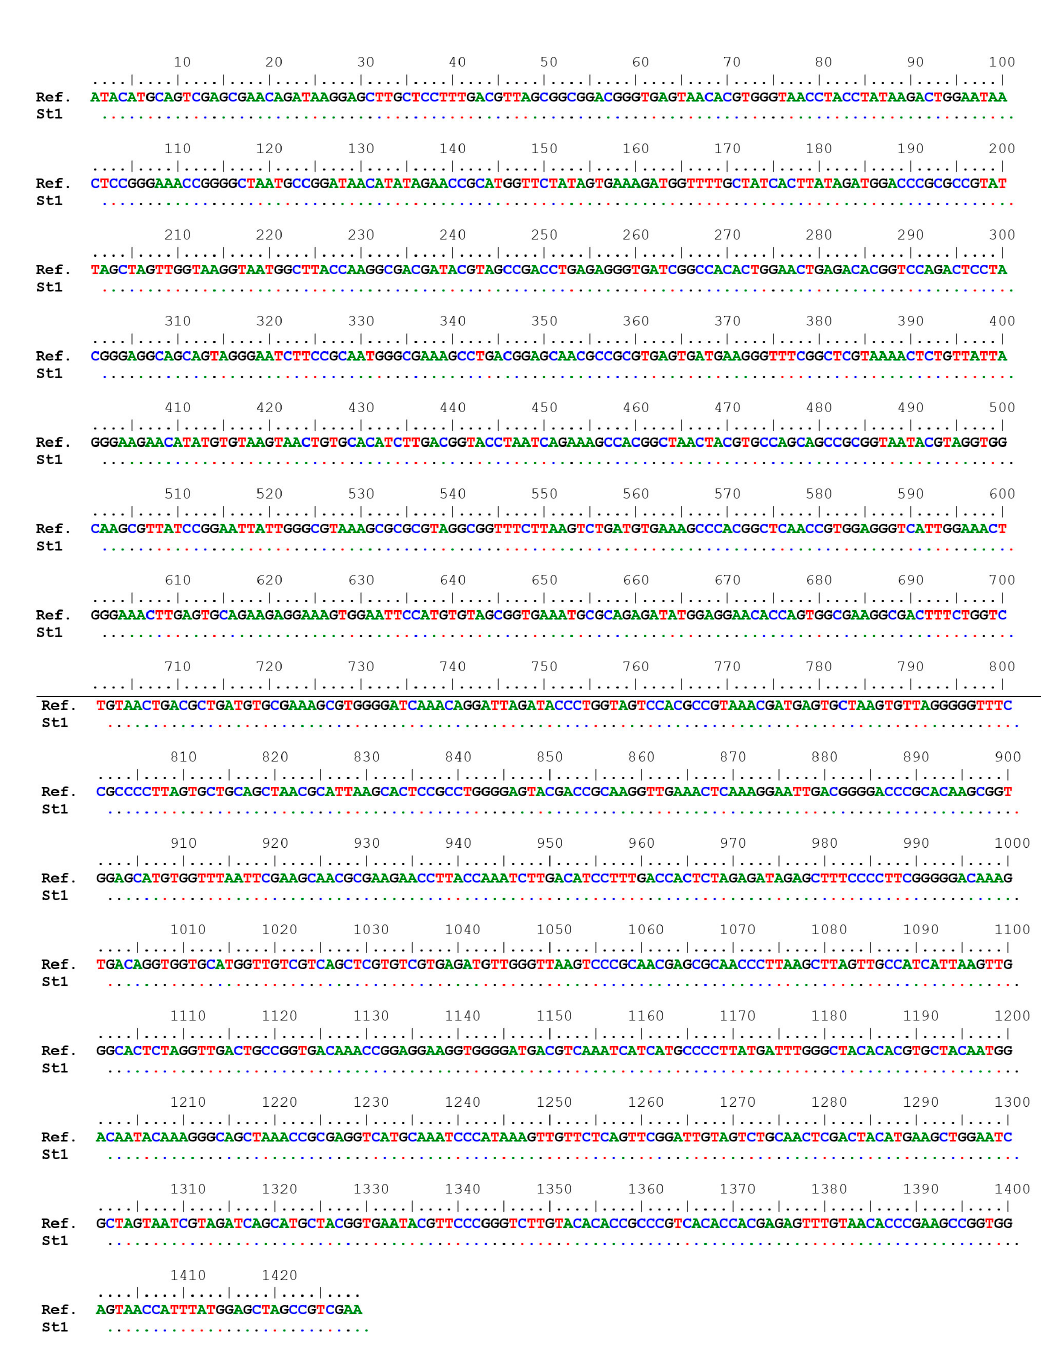
Fig. 2. DNA sequences alignment of the local sample of 16S rRNA with their corresponding reference sequences of the 1429 bp amplicons within Staphylococcus haemolyticus genomic